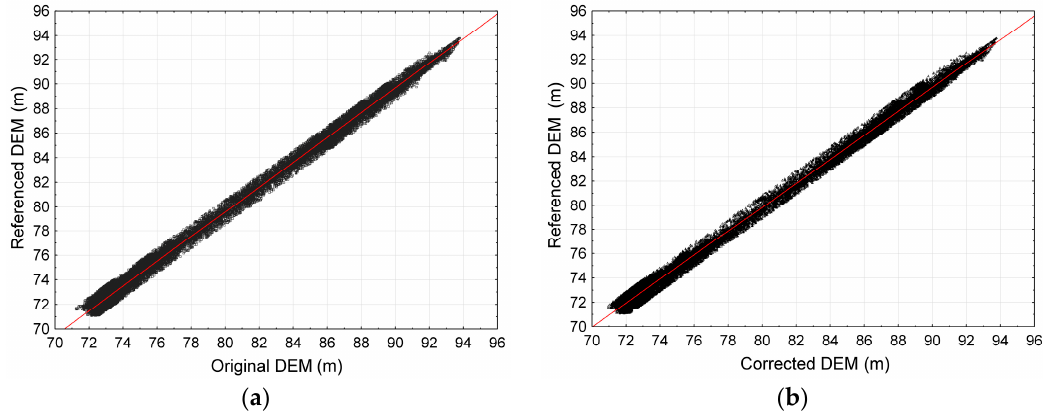
Figure 7. Relationship between the elevation according to the reference DEM vs. original DEM ( a ); and from the reference DEM vs. corrected DEM ( b ).